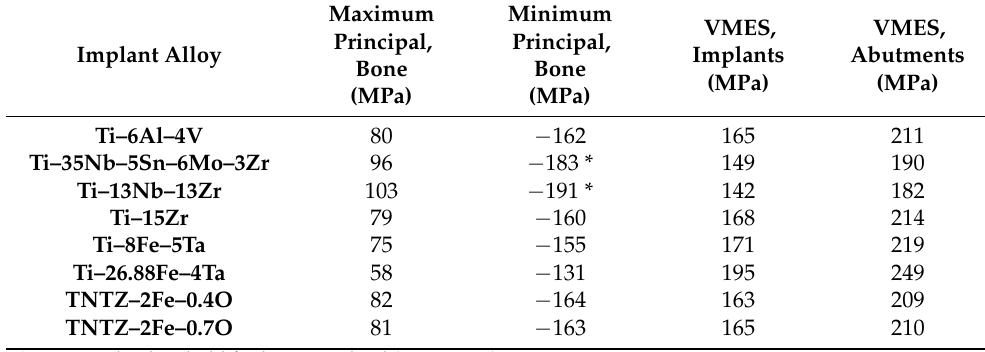
Table 2. Principal stresses and VMES values for alloy simulated in the implant of 2.7 mm in diameter.